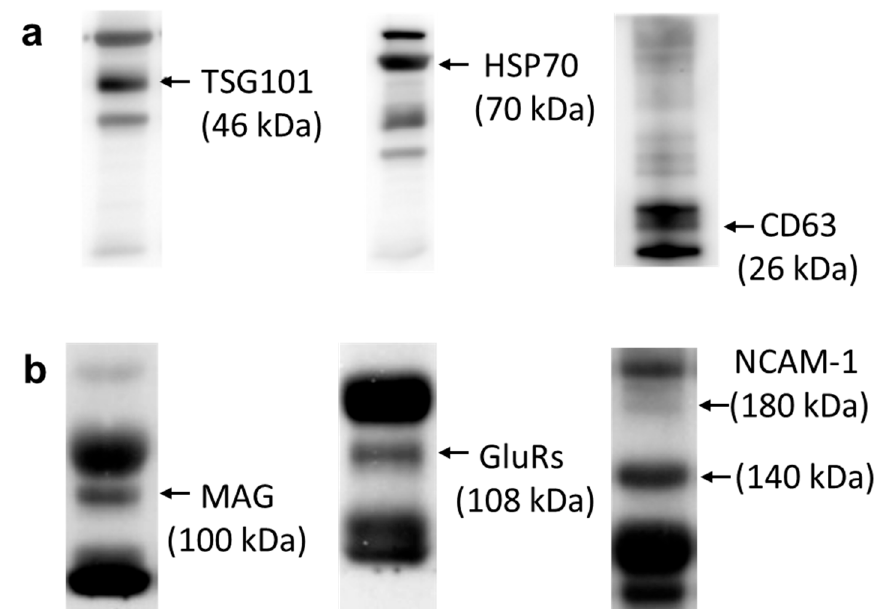
Figure 2. Western blotting analysis revealed that ( a ) exosomal markers TSG 101, HSP70, and CD63 were detected in the circulating serum exosomes. ( b ) Furthermore, the neuronal markers MAG, GluR 2&3, and NCAM-1 were also present in the serum exosomes from peripheral blood. CNS-derived exosomes were confirmed by neuronal markers.